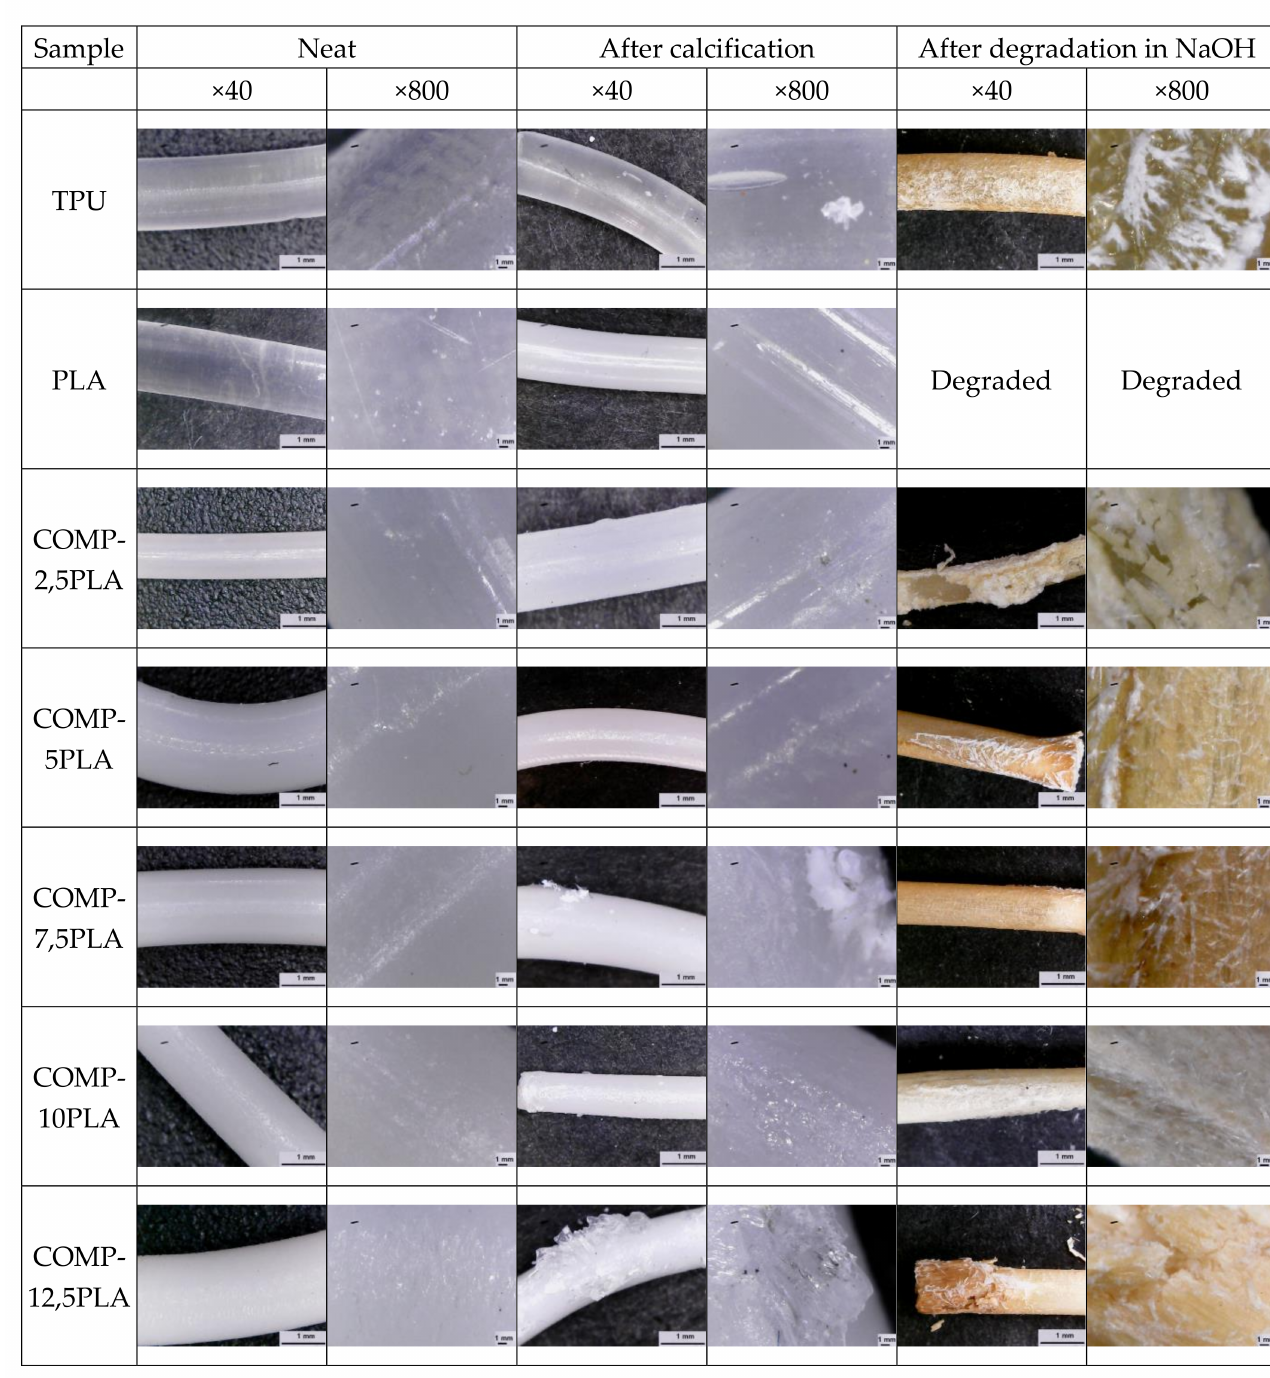
Figure 9. Micrographs of neat samples and after calcification and degradation in